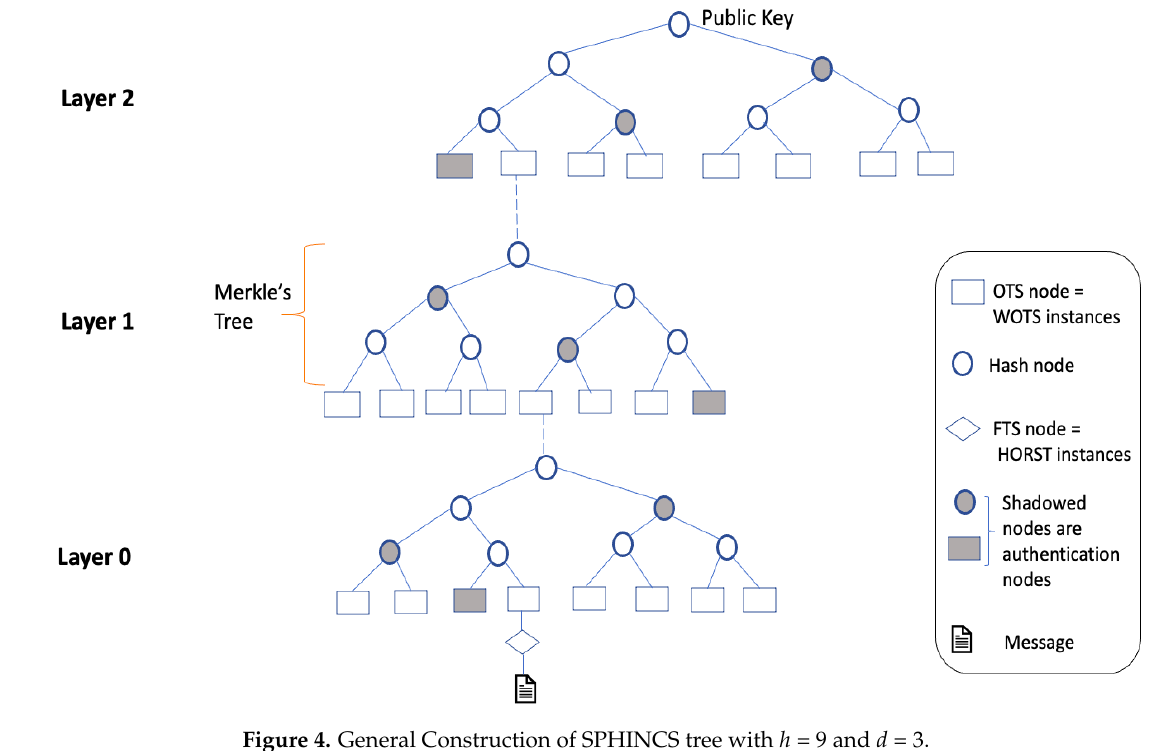
Figure 4. General Construction of SPHINCS tree with h = 9 and d = 3.